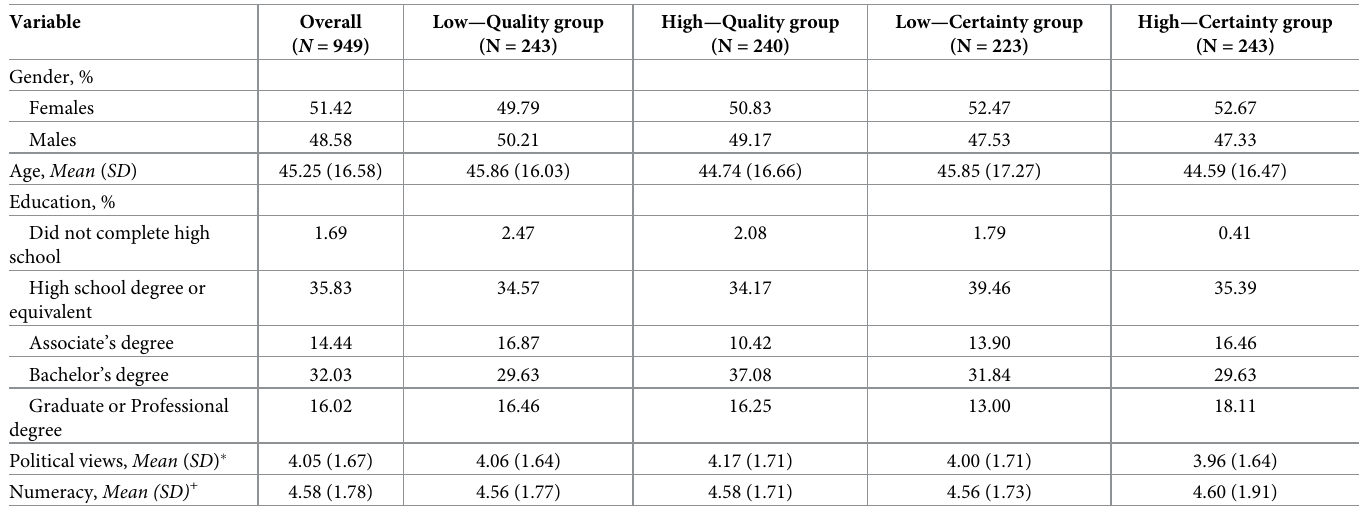
Table 2. Demographic details of participants in Experiment